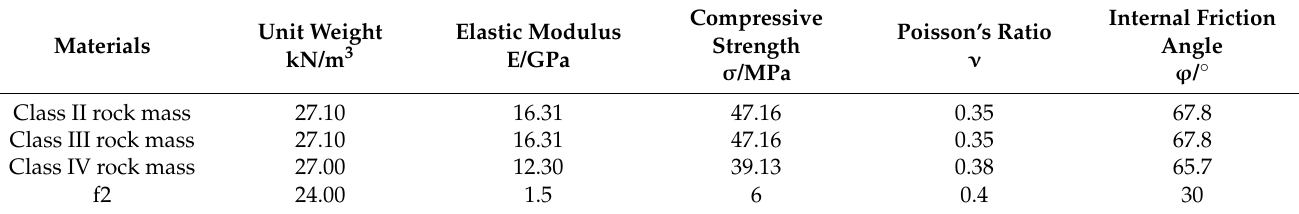
Table 5. The physical and mechanical parameters of the slope numerical model.